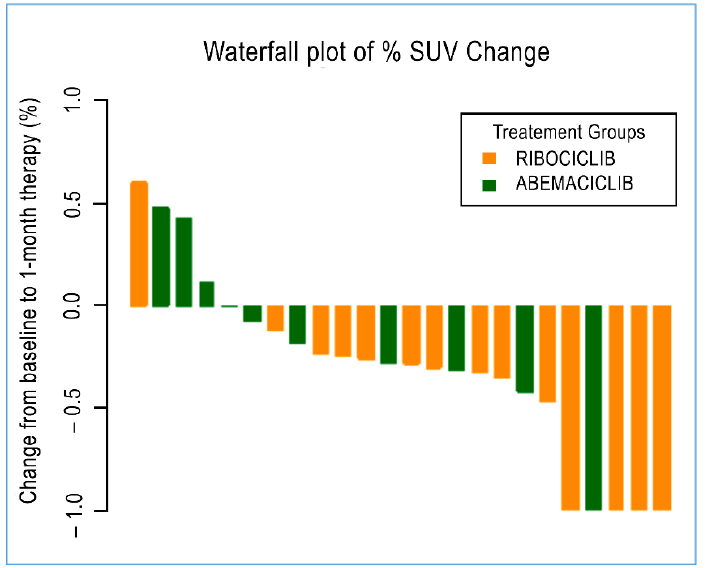
Figure 3. A waterfall plot of post-treatment changes in SUV from baseline for 24 evaluable